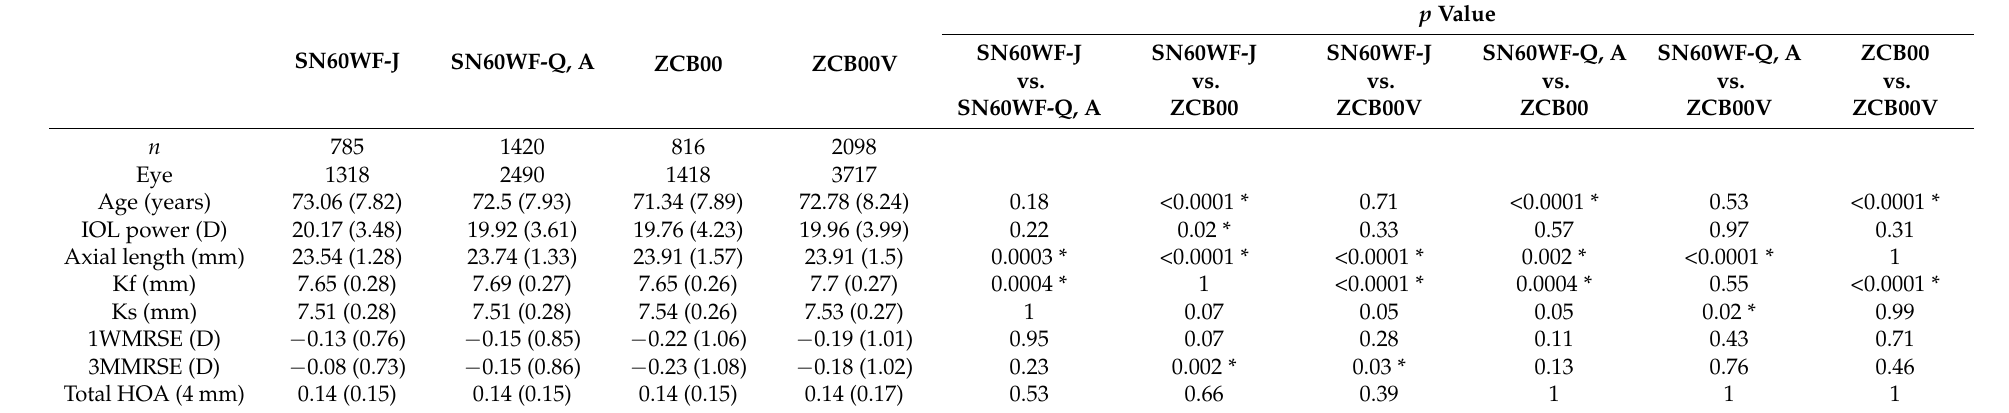
Table 1. Backgrounds and characteristics of patients in the four groups a